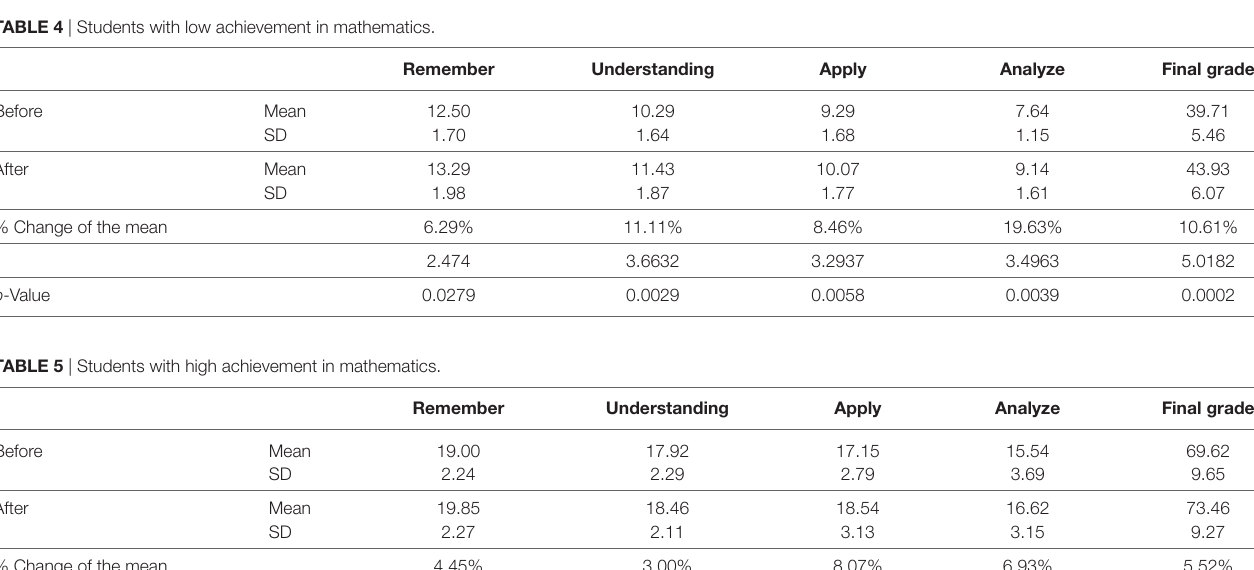
FigUre 1 | Representation of Bloom’s Taxonomy in the cognitive domain. The taxonomy provides a hierarchical model in order to categorize learning objectives in levels of specificity and complexity. Represented here is the knowledge-based cognitive domain that includes: remember (characterized by knowledge of specifics -terminology, specific facts, and ways); understanding (employing means of dealing with specifics them and knowledge of the universals and abstractions in a field such as understanding of facts and ideas by organizing, comparing, translating, interpreting, giving descriptions, and stating the main ideas); applying (involving acquired knowledge—e.g., problem solving in new situations); analyzing or breaking knowledge down into component parts; evaluating which is creating informed judgments and validating ideas and create which is the ability to create new